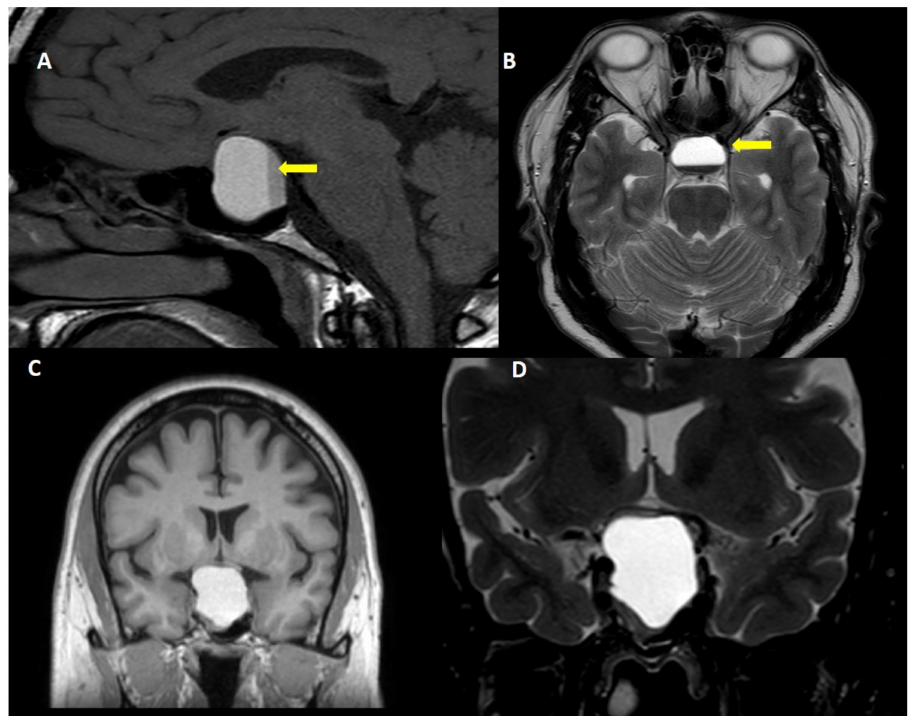
Figure 2. Acute pituitary apoplexy. A 40 year-old man, attended to in the emergency room due to sudden onset headache, vomiting and visual symptoms. ( A ): T1W sagittal view, ( B ): Fluid attenuated inversion recovery view, ( C ): T1W coronal view and ( D ): T2W coronal view. Note the fluid-fluid level within the tumor (yellow